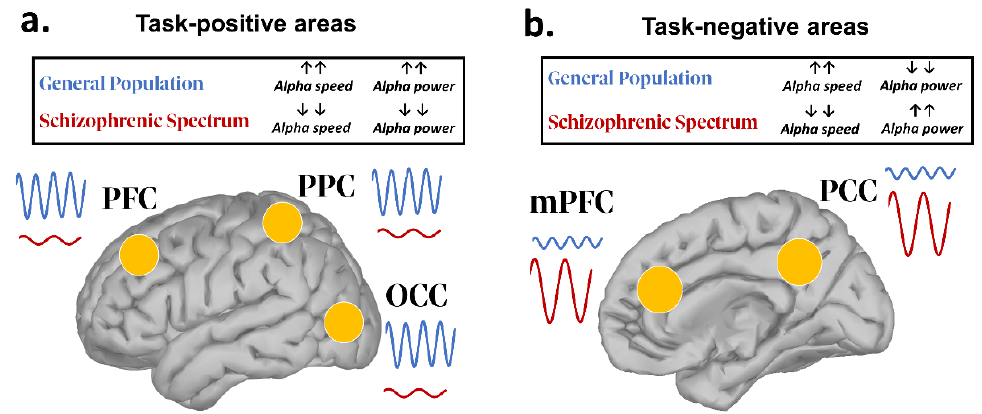
Figure 1. Graphical representation summarizing the main findings on resting-state alpha power in SSD (relative to healthy individuals). The left panel ( a ) depicts alpha oscillatory patterns relative to task-positive areas, while the right panel ( b ) depicts those relative to task-negative regions (largely overlapping with DMN’s nodes). Upward and downward arrows indicate respectively an increase or a decrease in alpha power or frequency speed. As for the former areas, alpha power is decreased, while the latter show an overall increase of such oscillatory index. PFC (prefrontal cortex); PPC (posterior parietal cortex); OCC (occipital cortex); mPFC (medial prefrontal cortex); PCC (posterior cingulate cortex) .